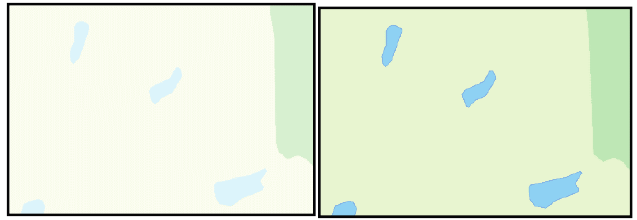
Figure 4. The same map area with different symbol styles. The TS map sample ( right ) was found to be more readable than the NS map sample ( left